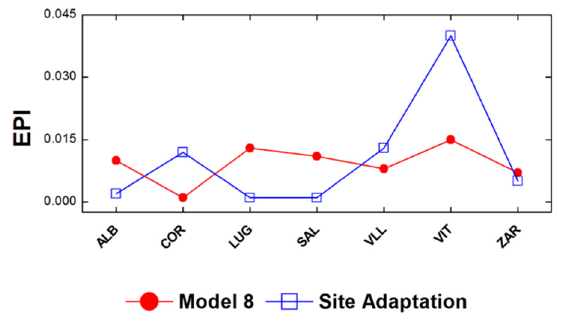
Figure 5. Comparison between the statistical results obtained by MR Model 8 and its site-adaptation correction.